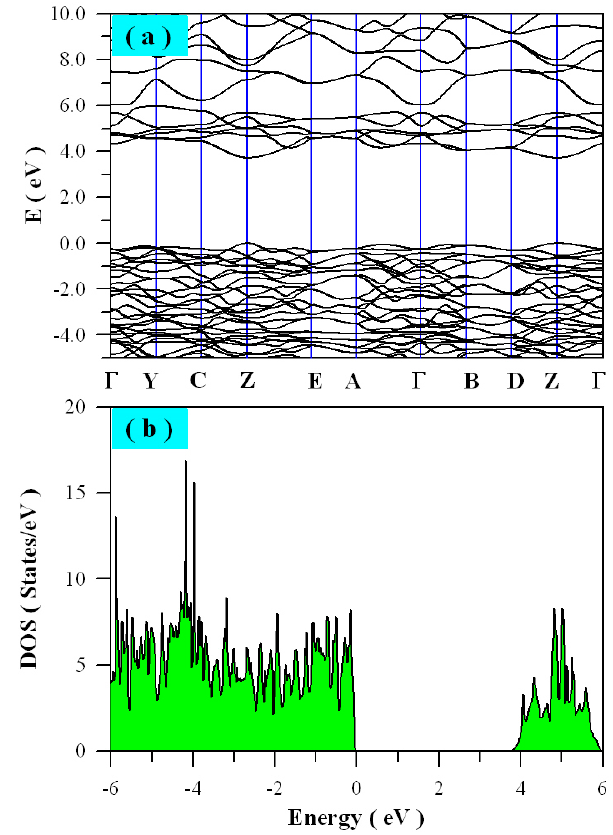
Figure 7. Band structures ( a ) and density of states ( b ) of defect-free ZnWO 4 derived via density functional theory (DFT) calculations in the scheme of generalized gradient approximation (GGA)+U.